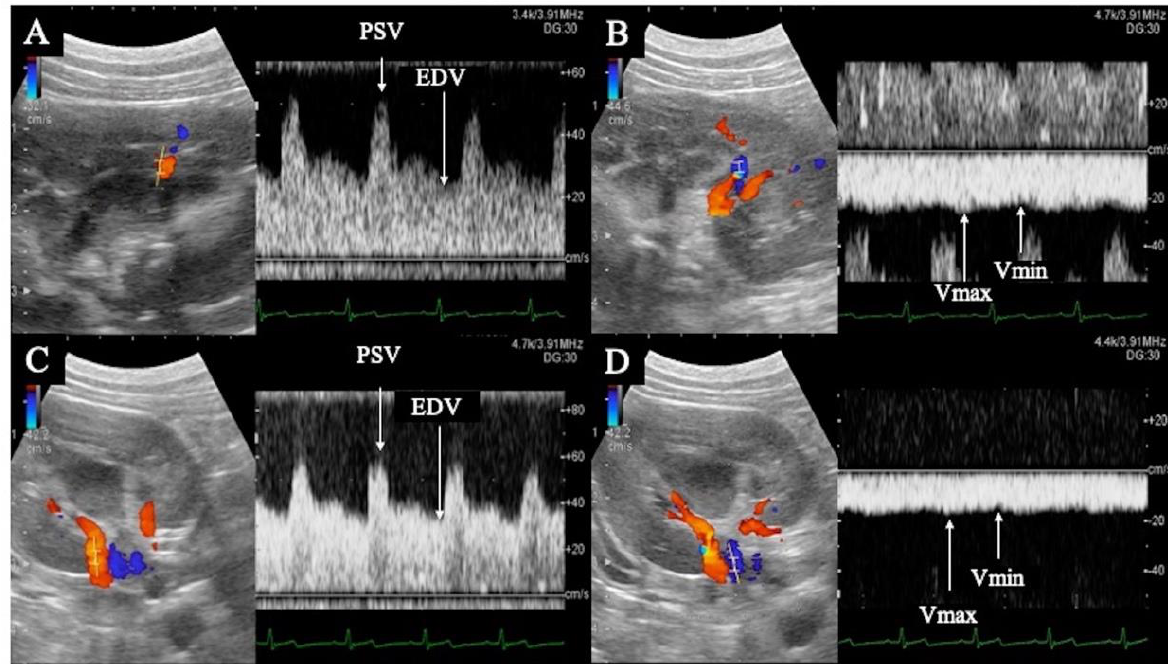
Figure 1. Flow waveform of the renal interlobar artery ( A ) and vein ( B ), and renal artery ( C ) and vein ( D ). ( A , B ) are horizontal sections of the kidney; ( C , D ) are transverse sections. The renal interlobar artery ( A ) and renal artery ( C ) show pulsatile waveforms with peak systolic velocity in systole (PSV) and end diastolic velocity (EDV) in diastole. The renal interlobar vein ( B ) and renal vein ( D ) show flat, continuous waveforms; the maximum velocity is Vmax and the minimum velocity is Vmin.